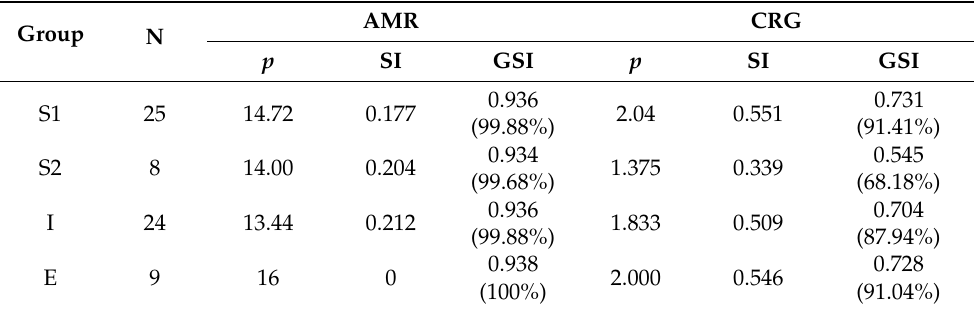
Table 2. Proportional abundance of antibiotic resistance phenotypes and carbapanemase genes in K. pneumoniae Kp1 isolated from